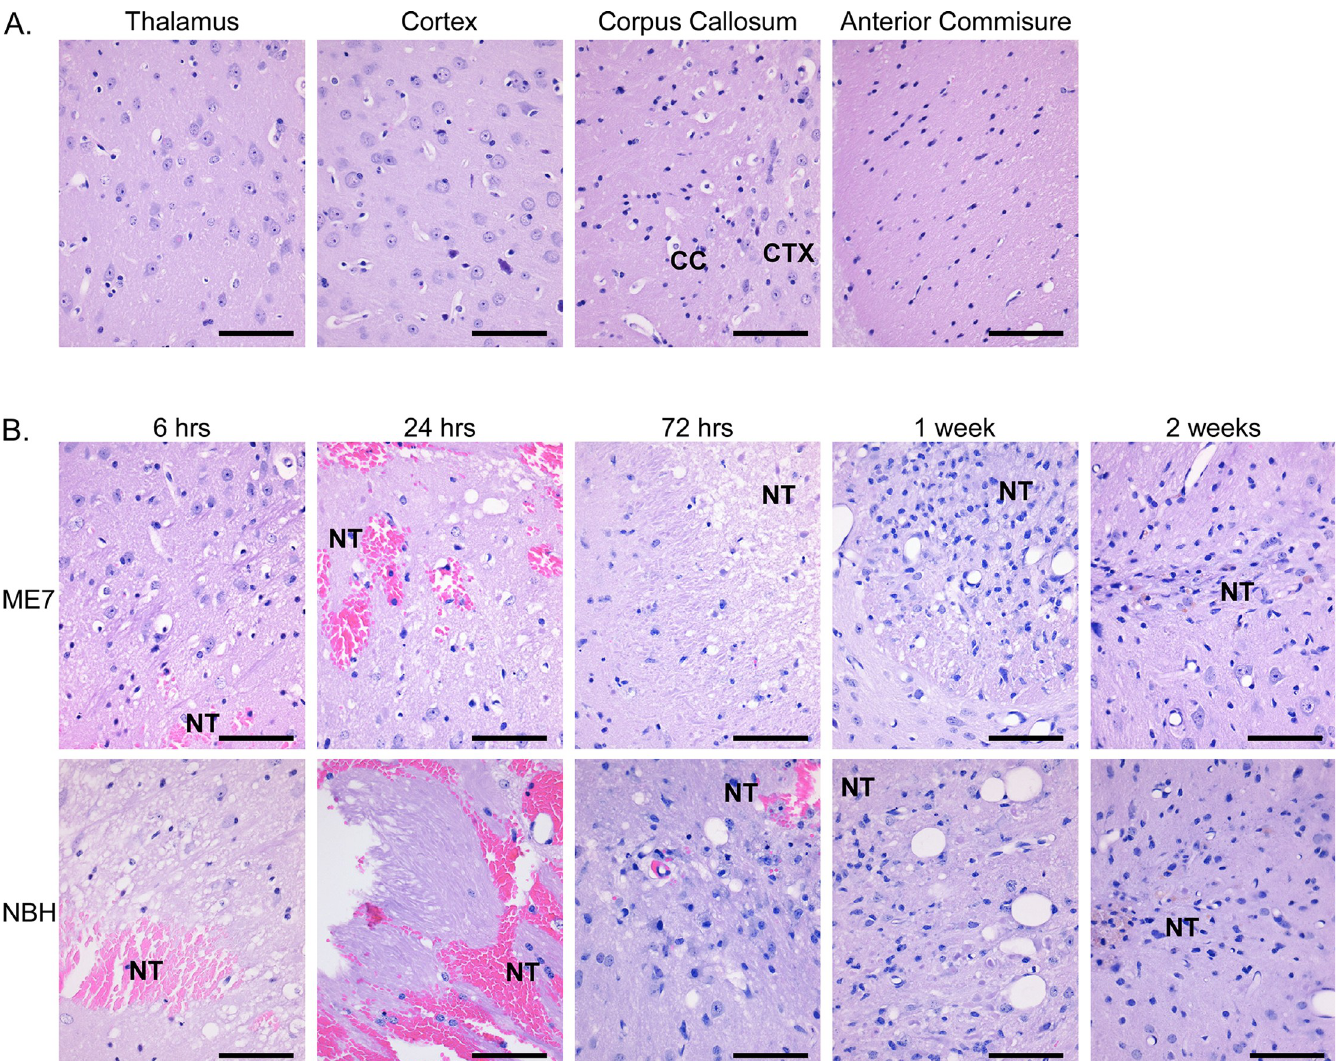
Fig 1. H&E stain of brain tissue of Tg3F4 mice following inoculation with ME7 prions or NBH. (A) H&E staining of different brain regions of uninoculated Tg3F4 mice. (B) H&E staining of brain tissue at different timepoints following the inoculation of mouse brain homogenate from mice infected with ME7 prions (upper row) or NBH (lower row). All sections are from the thalamus except for the ME7 6 hr timepoint (cortex/corpus callosum), the NBH 24 hour (fornix) timepoint, and the ME7 2 week timepoint (hypothalamus). Tissue loss is evident in the region surrounding the needle track. The sections shown are representative of the 4 animals analyzed at each timepoint. CC = corpus callosum; CTX = cortex; NT = needle track. Scale bar = 50 μ